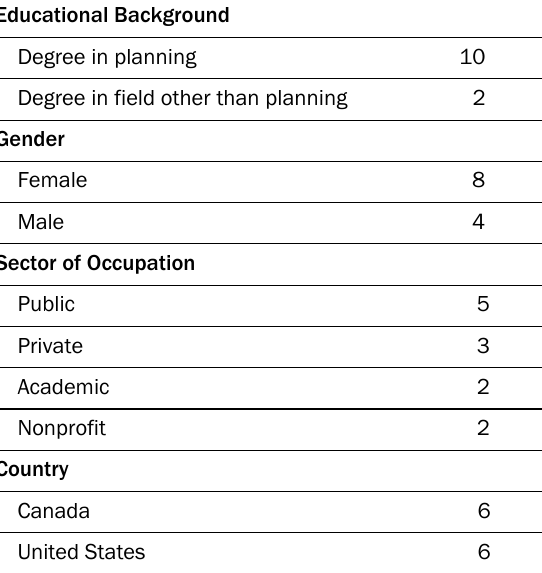
Table 2. Summary of Interviewee